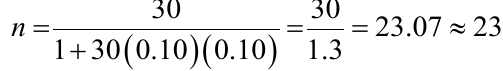
Table 1. Research variables and their measurement Variable